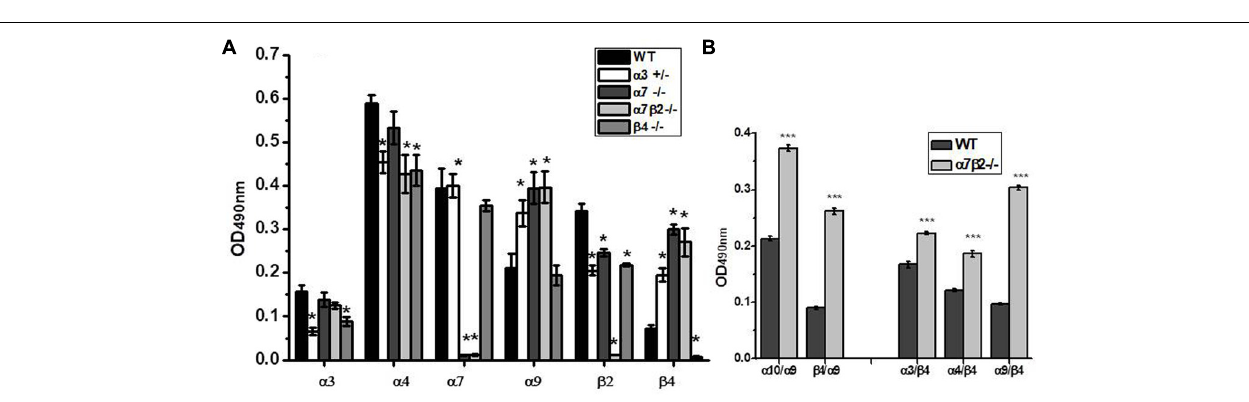
α 4 β 2-specific Dh β E or α 3 β 2-specific α -conotoxin MII